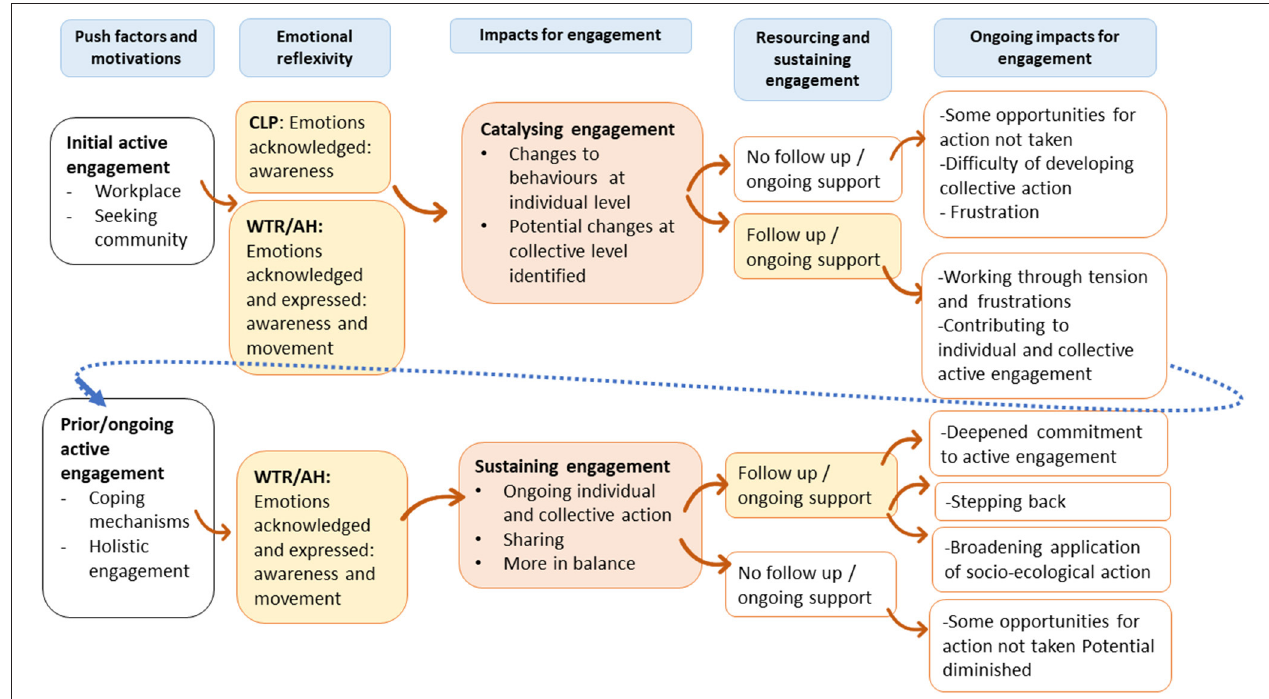
FIGURE 1 | Schematic showing how emotional reflexivity was developed through participating in the CLP or WTR/AH and the impact on active